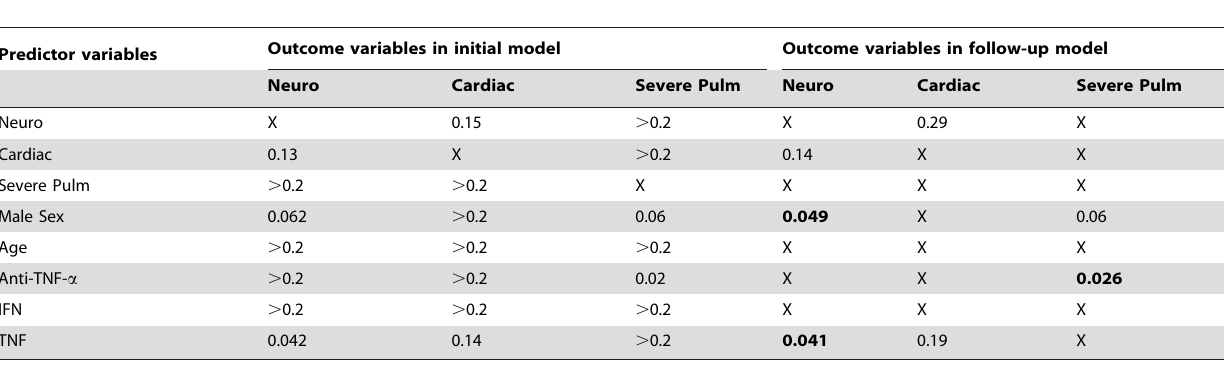
Table 2. P values obtained from stepwise multivariate logistic regression modeling of sarcoidosis phenotypes in African-American sarcoidosis patients.